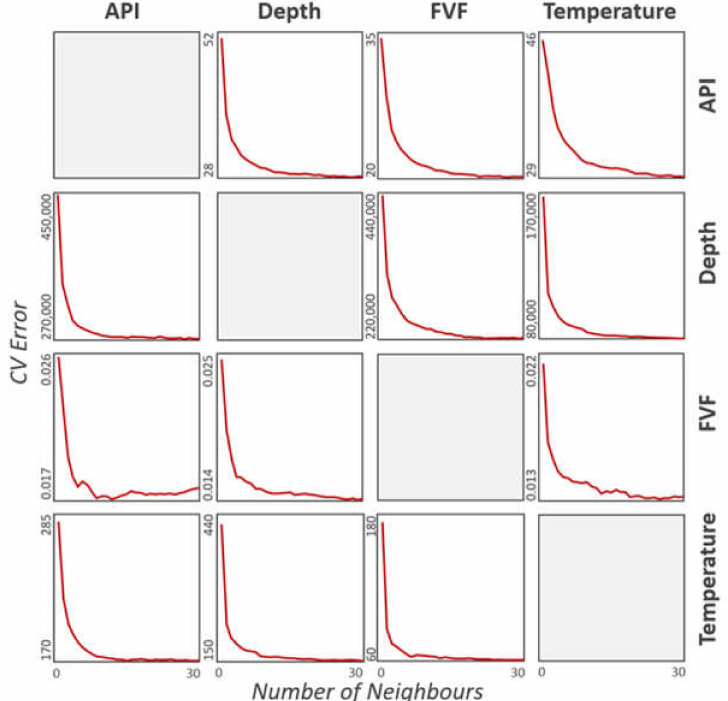
Figure 14. KNN cross-validation (CV) error curves for each variable (API, depth, FVF, temperature) in 2-dimensional space. The input feature is listed on the horizontal axis, and the target variable listed on the vertical. Where the error curve (red) has a declining shape with increasing number of neighbours ( x -axis), the target variable does not depend on the distance between the input data and is therefore not relevant to input